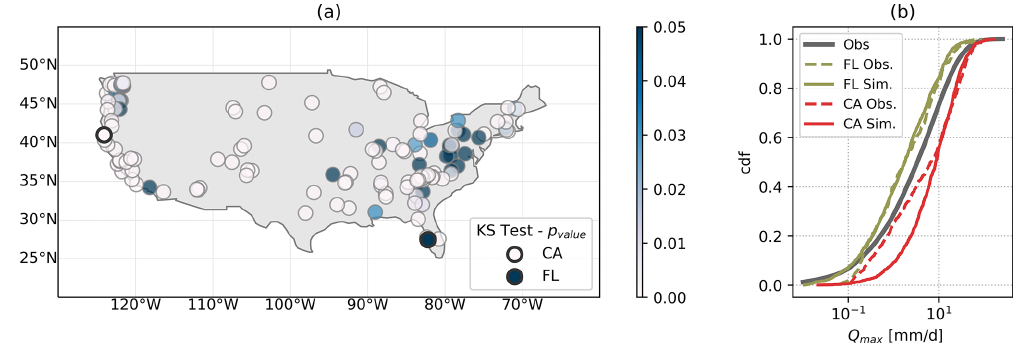
Figure 8. Results from the KS test on the SN-C network. Panel (a) shows the p value of the KS test results at the corresponding catchment location. A p value ≤ 0.05 indicates that H 0 is rejected. Two locations are highlighted: station no. 11481200 in California and station no 02299950 in Florida. Such stations are further analysed in panel (b) . Here, the solid grey line indicates the cumulative distribution function modelling the Q max node in the SN-C network. The red lines represent the observed (dashed) and simulated (solid line) Q max distribution at the catchment in California. The green lines represent the observed (dashed line) and simulated (solid line) Q max distribution at the catchment in Florida. The comparison of the coloured lines with the grey line shows that by conditioning on catchments’ attributes, the SN-C network returns discharge values in the range of the discharge observable at the catchment. The comparison between solid and dashed lines of the same colour indicates whether conditioning on attributes is sufficient for a good discharge estimation. In Florida the model performs well (the two lines overlap), while in California the model cannot reproduce low quantiles